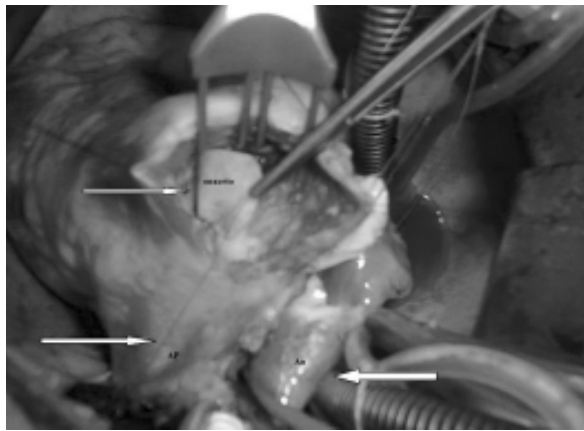
Fig. 3 – Retalho de pericárdio bovino na parede do ventrículo direito, que foi utilizado para fechar o orifício do aneurisma. A seta inferior esquerda mostra tronco da artéria pulmonar e a da direita mostra a aorta ascendente e veia cava superior